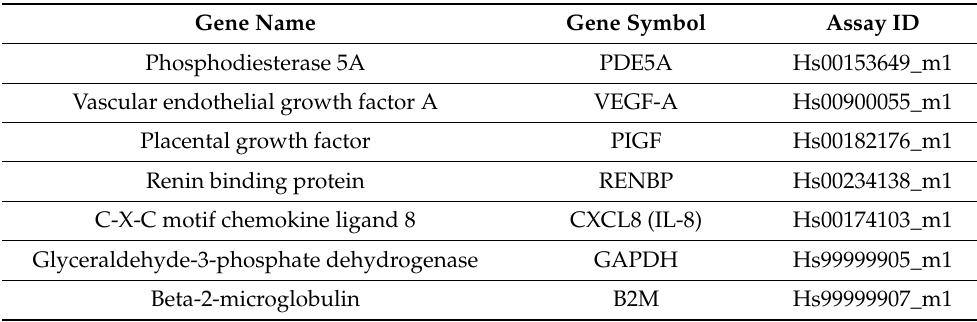
Table 1. TaqMan probes used for RT-PCR in determination of the gene expression of selected angiogenic